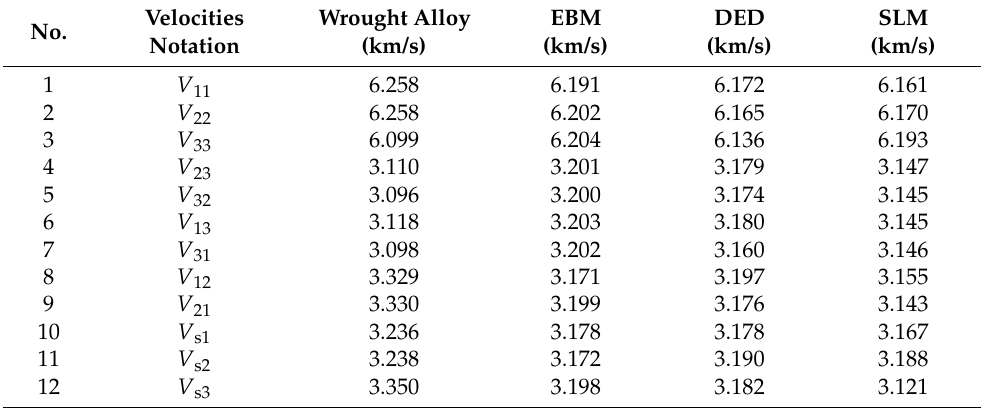
Table 3. Sound wave velocities (SWVs) in the commercial wrought Ti6Al4V alloy sample and in the three AM Ti6Al4V samples ( n = 6). The maximum error (calculated based on the standard deviation and instrumental error) in the longitudinal SWV is 6 m/s, the maximum error in the shear SWV is 10 m/s. No.